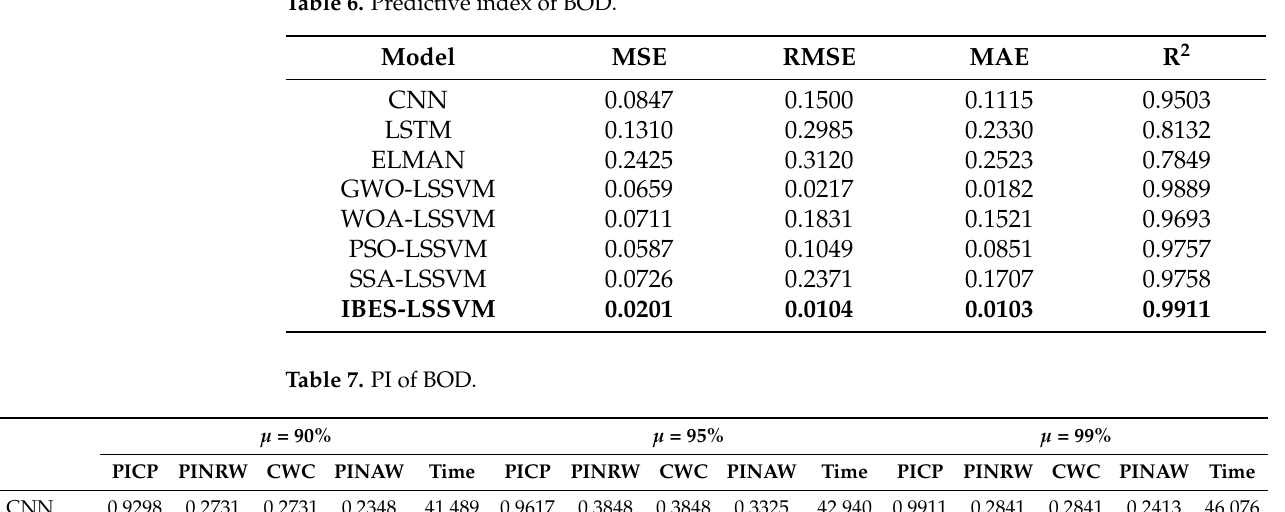
Figure 13. 90% of BOD. Table 6. Predictive index of BOD.